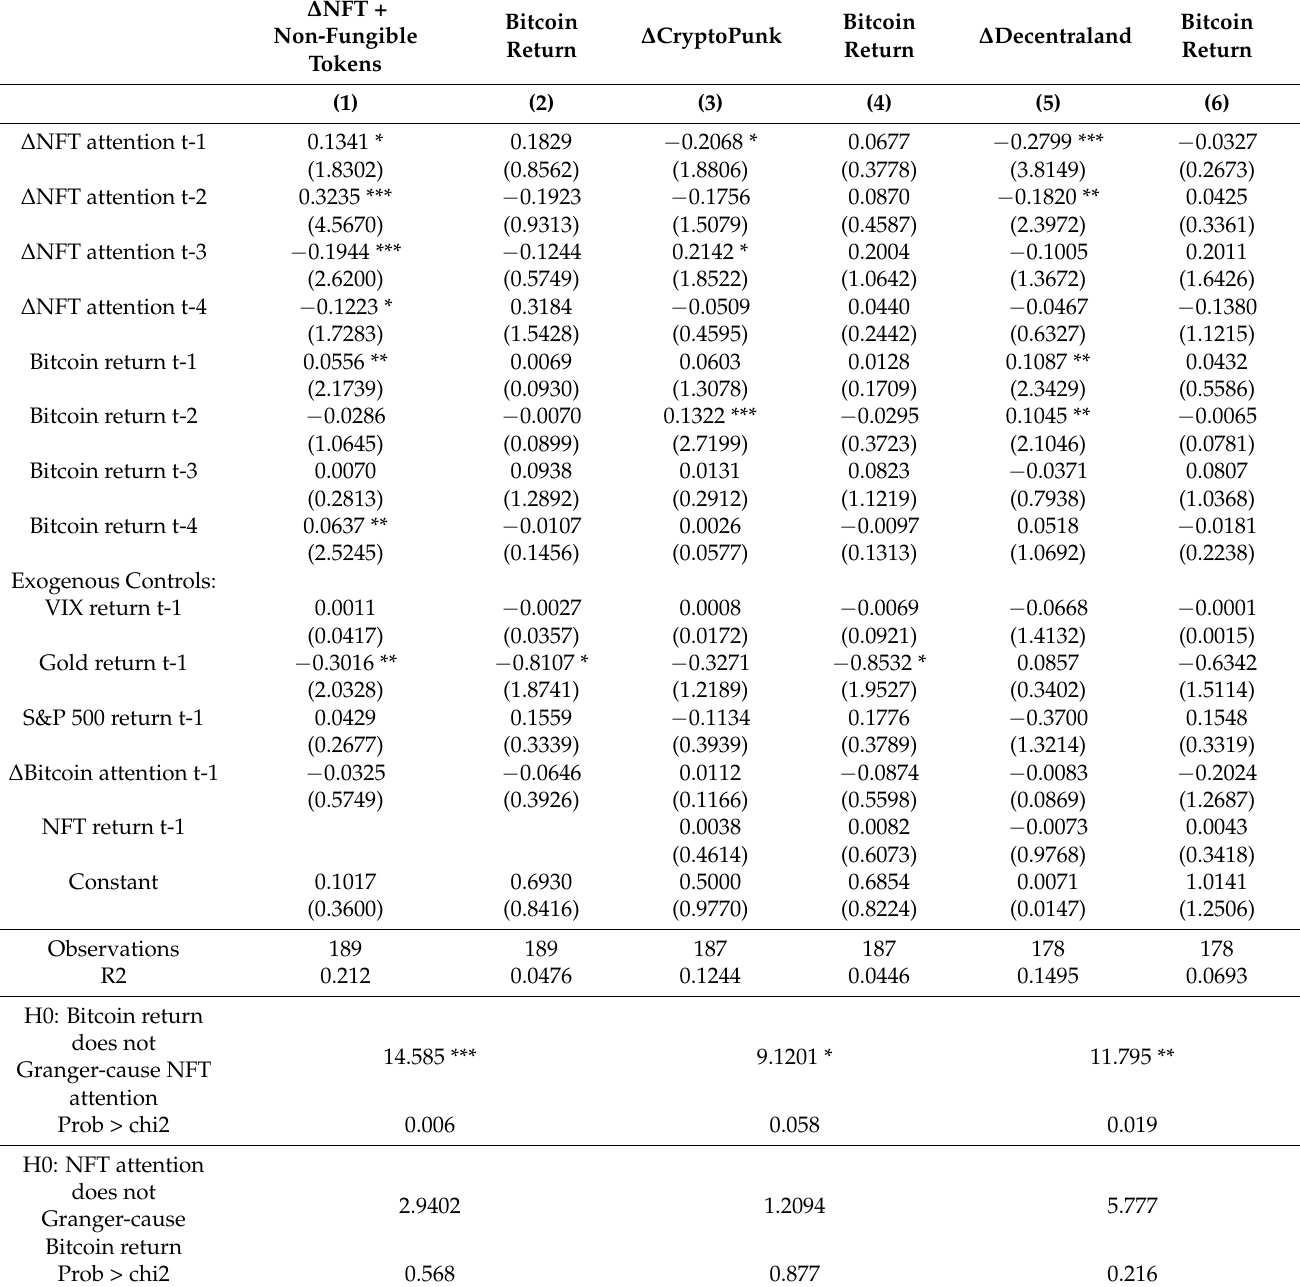
Table 2. Dynamic relationships among NFT attention and Bitcoin